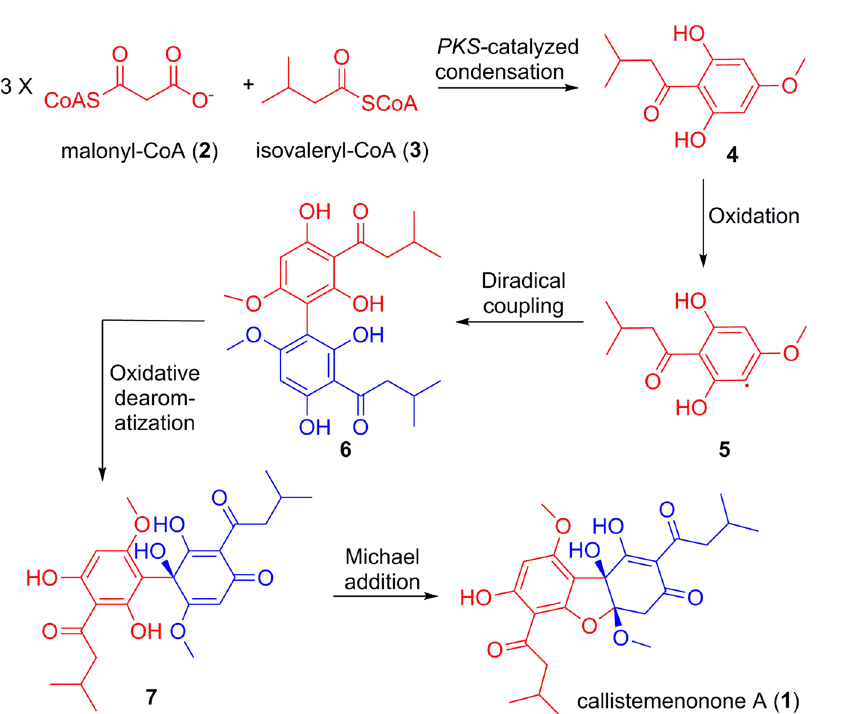
Figure 4. Proposed biogenesis of callistemenonone A ( 1 ).